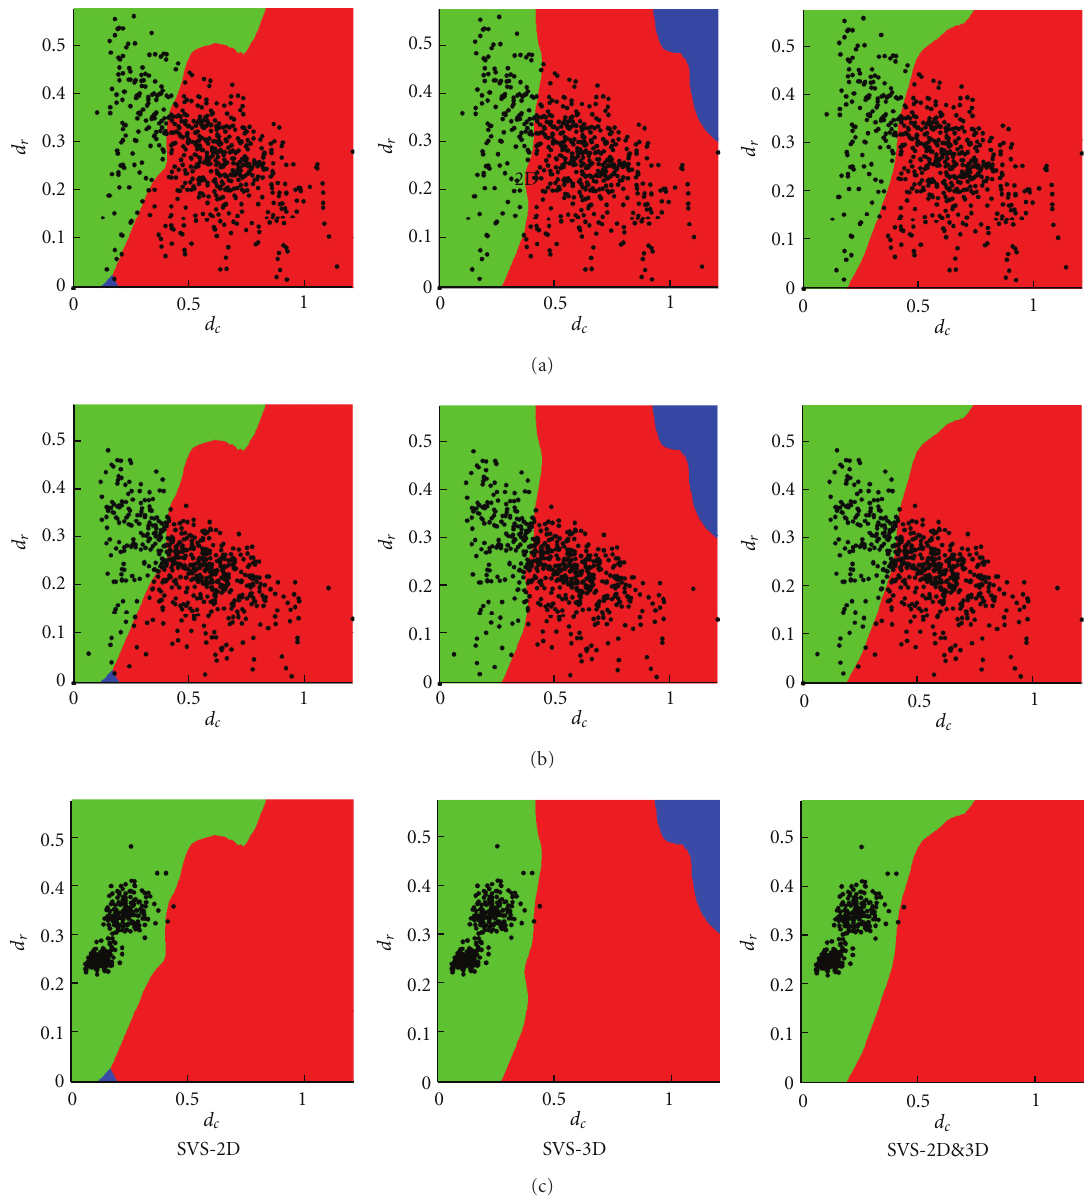
Figure 7: Scatter plots of the ( d c , d r ) pairs for all the tests of the (a) 2D and (b) 3D testing sets, and (c) real data set, overlaid on the SVS selection regions described in Figure 4 for (left) SVS-2D, (middle) SVS-3D, and (right) SVS-2D&3D. We note that the three versions of SVS selected SBA as the most appropriate method for nearly all tests of the real data set